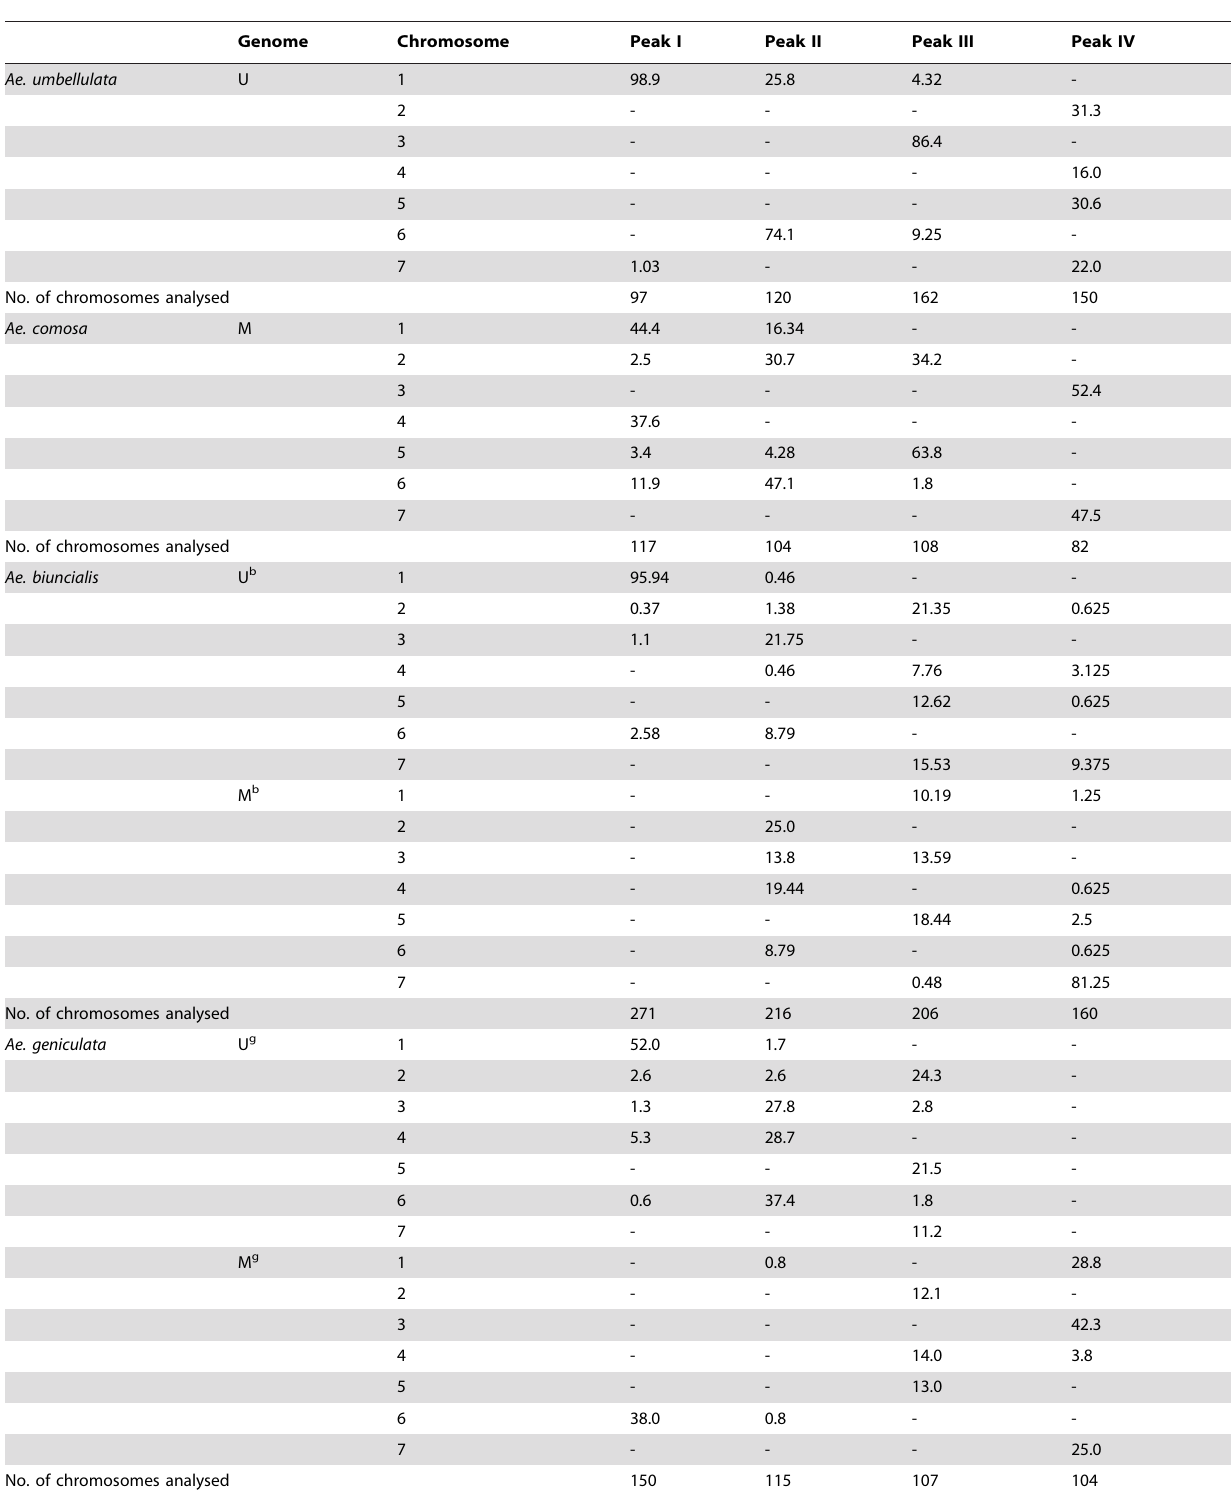
Table 2. Assignment of chromosomes to peaks of flow karyotypes of Ae. umbellulata , Ae. comosa and their natural tetraploid hybrids Ae. biuncialis and Ae. geniculata